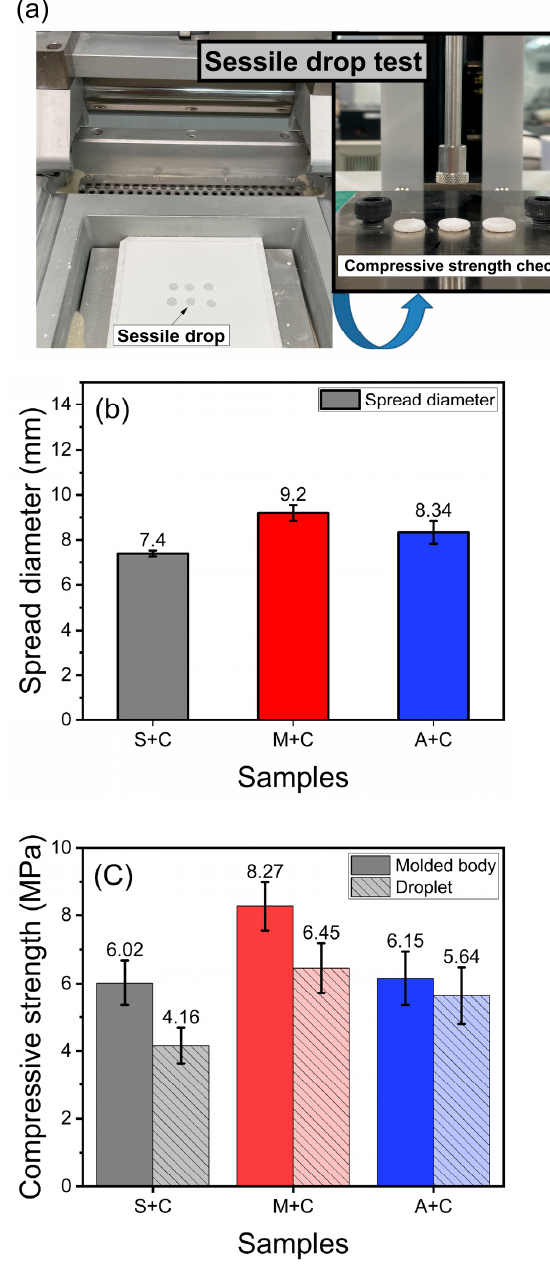
Figure 9. Powder bed sessile drop test: ( a ) Proceed with sessile drop test using sessile drop tester, ( b ) spread diameter as a result of sessile drop test, ( c ) compressive strength as a result of sessile drop test.